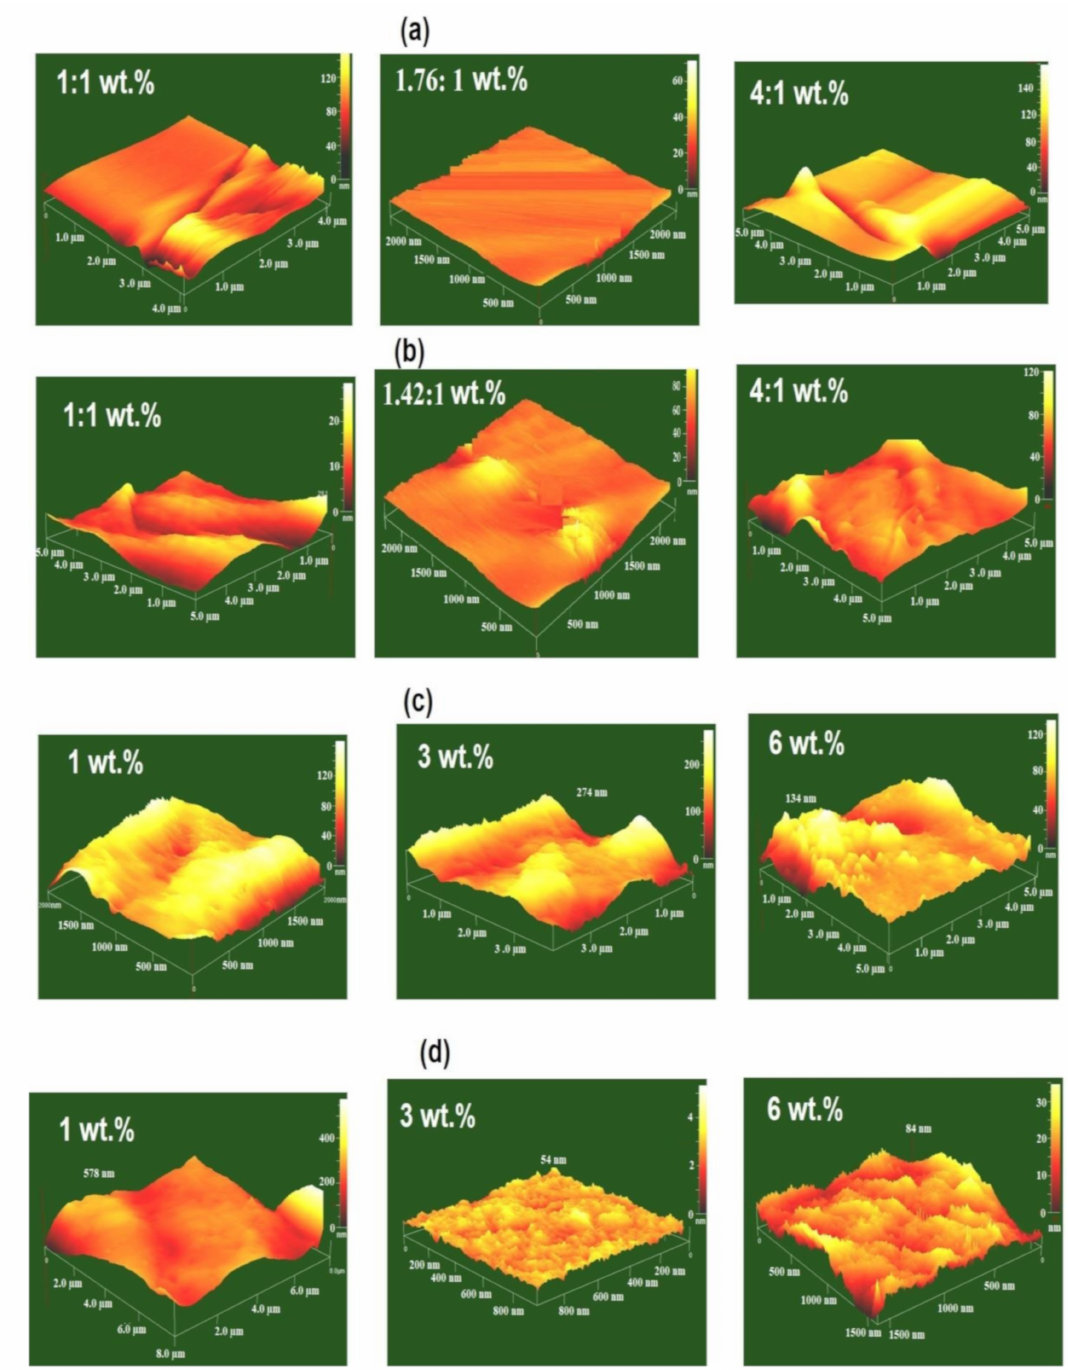
Figure 12. Atomic force microscope (AFM) photos of ( a ) DGEB / HPHI in the absence of HPHI-Fe 3 O 4 , ( b ) DGEB / DCHI in the absence of DCHI-Fe 3 O 4 , ( c ) DGEB / HPHI in the presence of HPHI-Fe 3 O 4 , and ( d ) DGEB / DCHI in the presence of DCHI-Fe 3 O 4